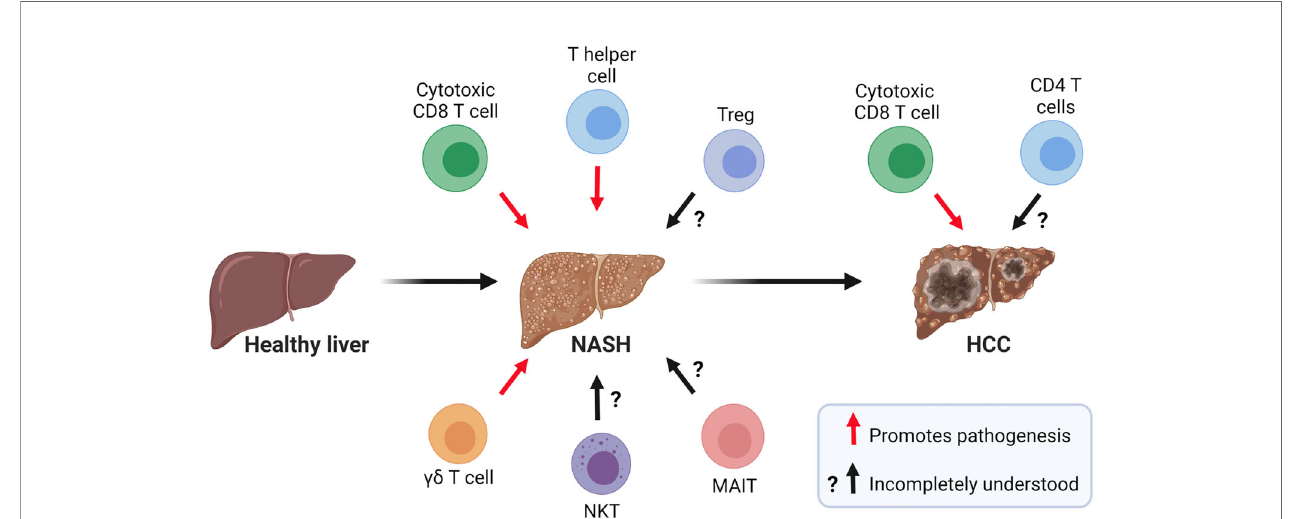
FIGURE 2 | Role of T cells in the pathogenesis of NASH and NASH-related HCC. Current evidence suggests that CD8 T cells, CD4 T helper cells, and gd T cells contribute to NASH pathogenesis. The role of NKT cells, MAIT cells, and Tregs in NASH is incompletely understood. In NASH-related HCC, a subset of activated and exhausted CD8 T cells promote tumorigenesis while the role of CD4 T cells in this process warrants further investigation. (Created with